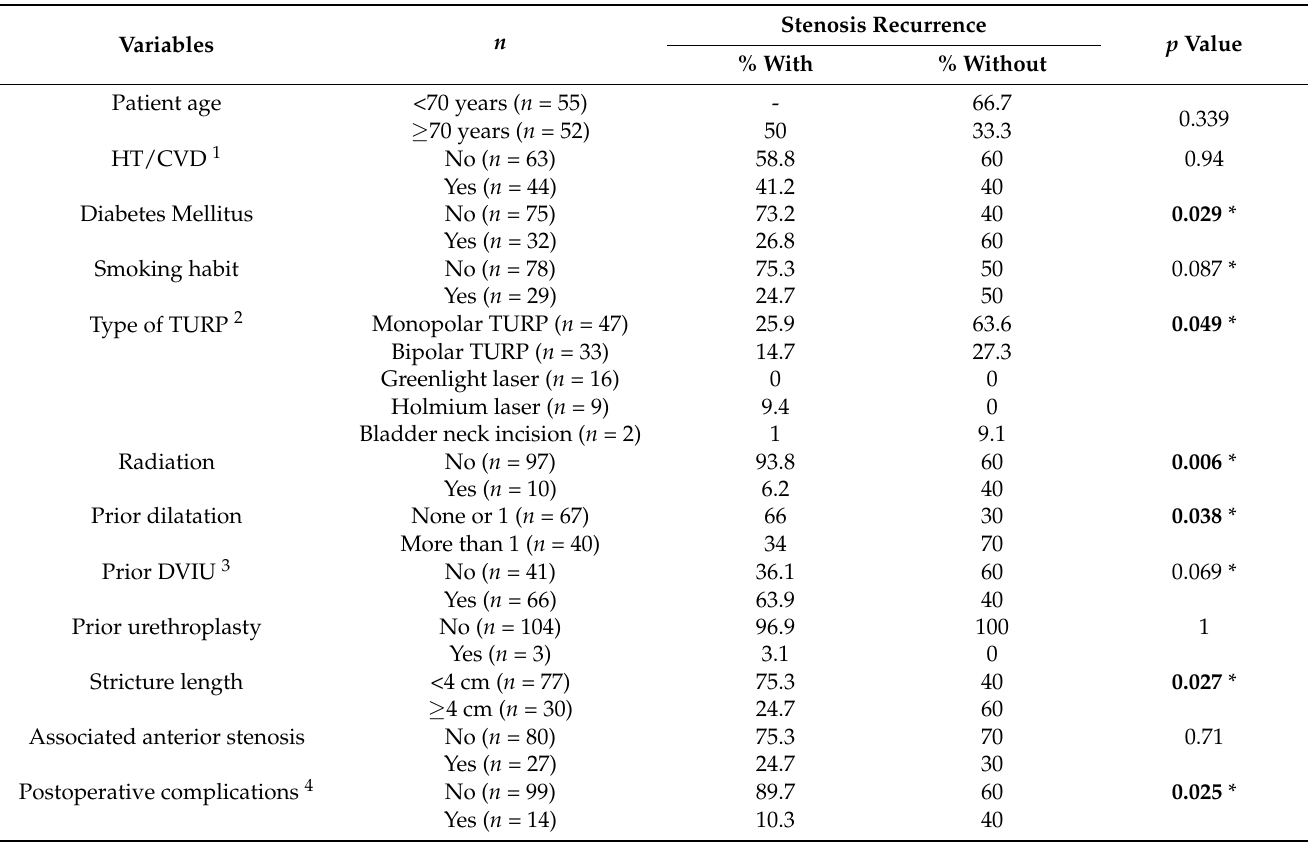
Table 2. Association between stenosis recurrence and clinical features. Variables with statistical significance ( p < 0.05) are highlighted in bold; variables with p < 0.1 were considered for the stepwise model regression analysis (*). 1 HT/CVD, hypertension and/or cardiovascular disease; 2 TURP, transurethral resection of the prostate; 3 DVIU, direct vision internal urethrotomy; 4 According to Clavien–Dindo classification within 90 postoperative